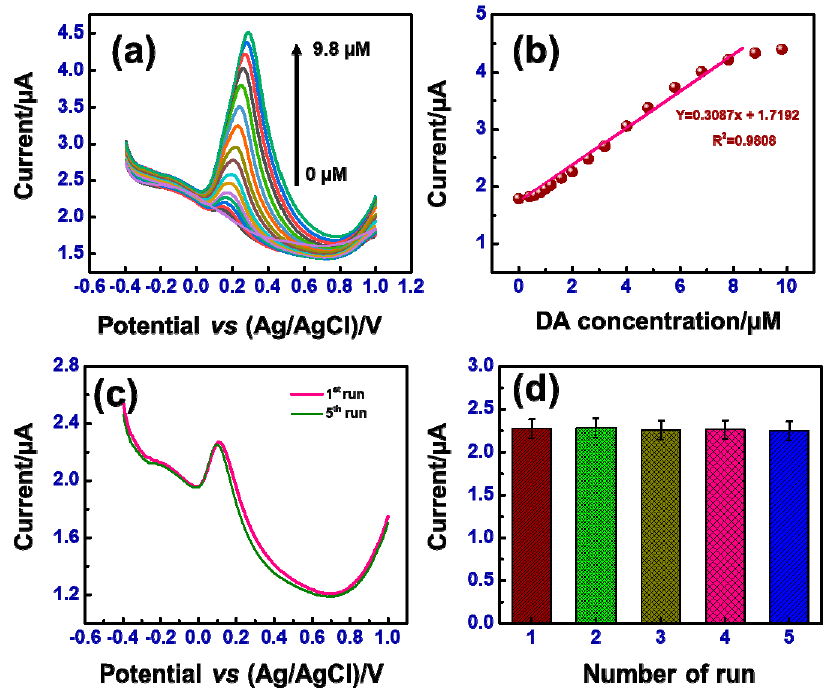
Figure 7. ( a ) Di ff erential pulse voltammetry (DPV) response of the CeO 2 / siloxene-modified electrode in 0.1 M PBS solution containing di ff erent concentrations of DA; ( b ) Linear response of the oxidation current versus DA concentrations; ( c ) Repeatability of a modified electrode in the presence of 1 µ M of DA-containing 0.1 M PBS solution; ( d ) Plot of the oxidation current versus the run number for five consecutive measurements.